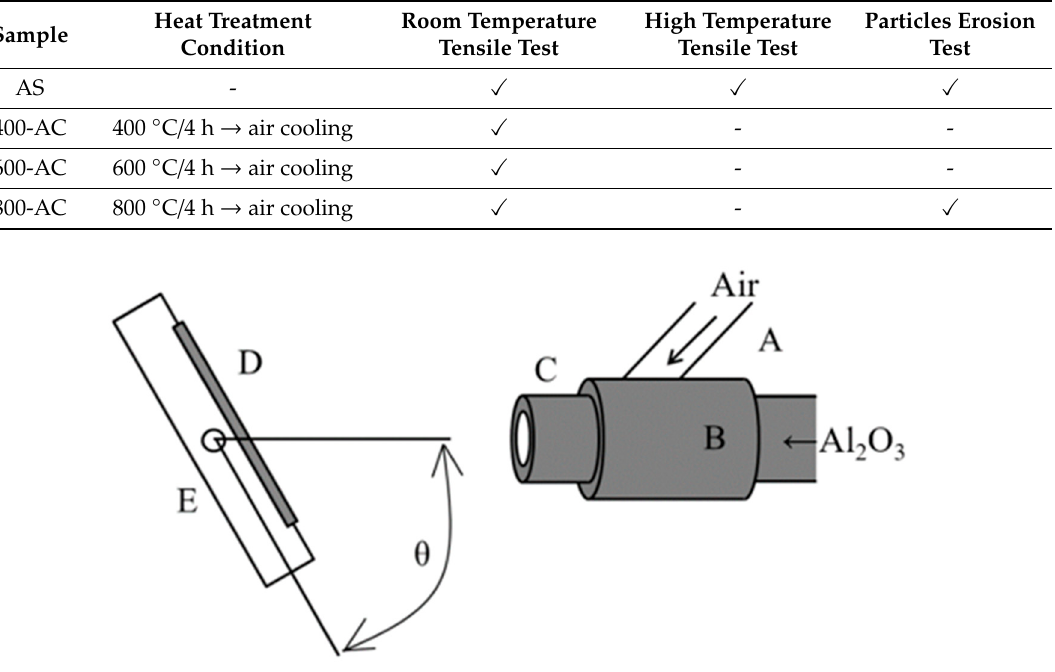
Figure 2. The particle erosion test apparatus. ( A ) Compressed air flow, ( B ) erosion particle supplier, ( C ) erodent nozzle, ( D ) specimen, and ( E ) specimen holder; θ = impact angle).